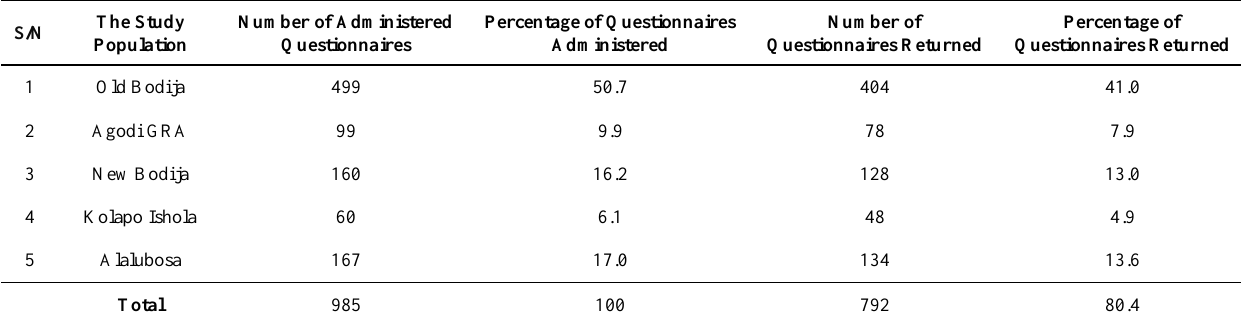
Table 2. Distribution of Administered and Returned